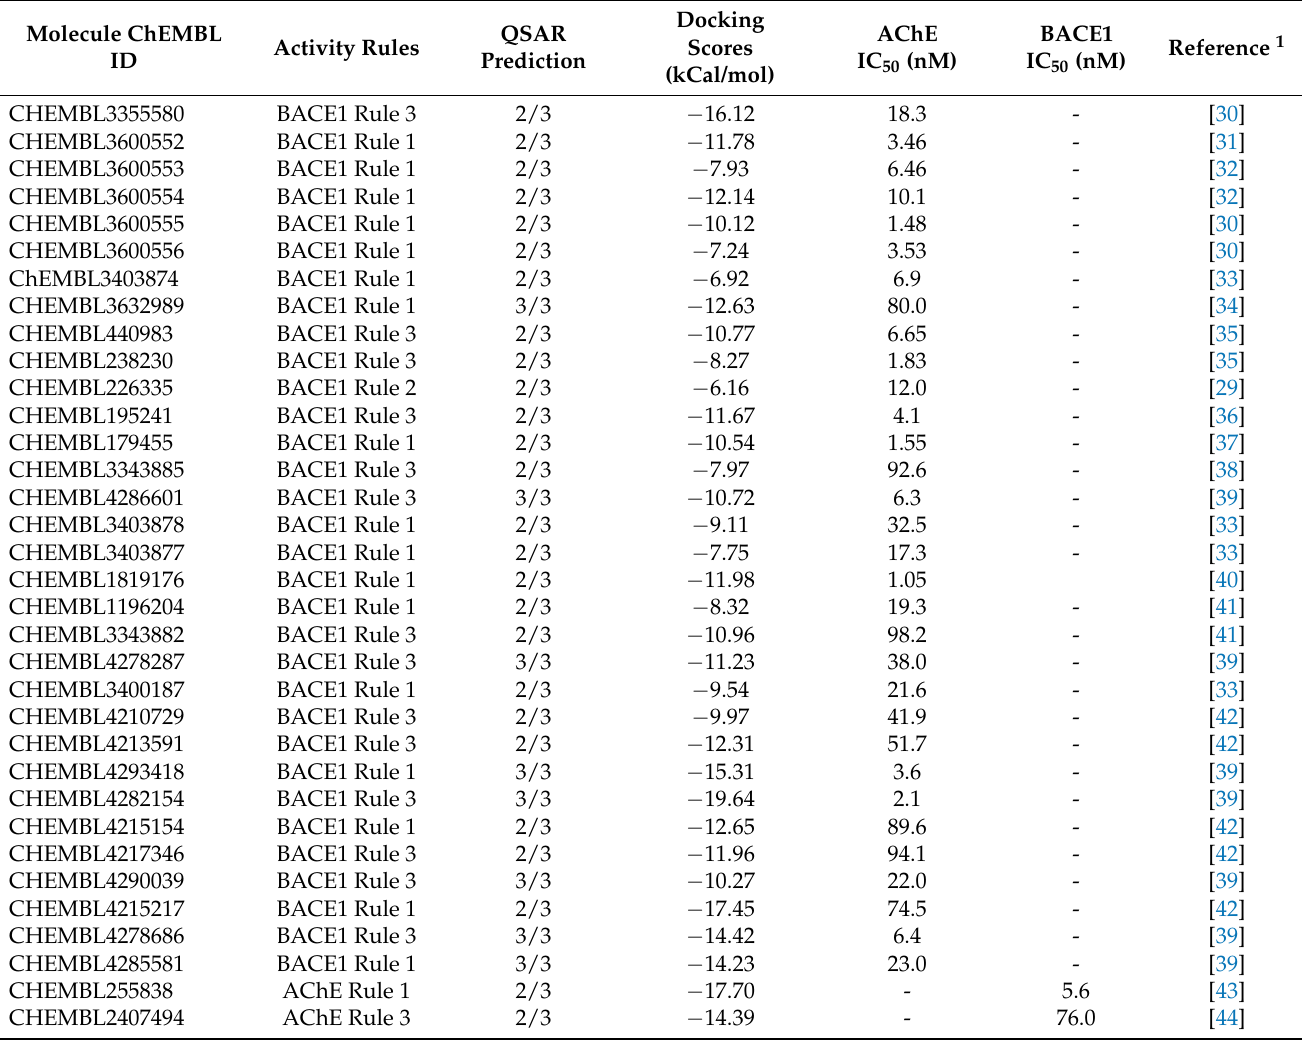
Table 5. AChE and BACE1 dual inhibitors screened by experimental and rule-based